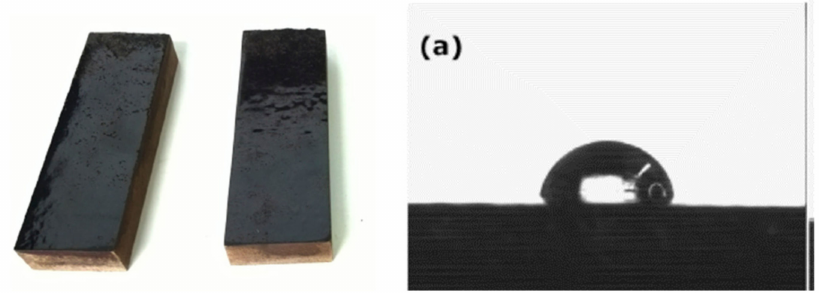
Figure 11. Non-isocyanate polyurethane-based (NIPU) wood surface coatings based on condensed tannins ( left ) and sessile water drop contact angle on the NIPU coating surface ( right